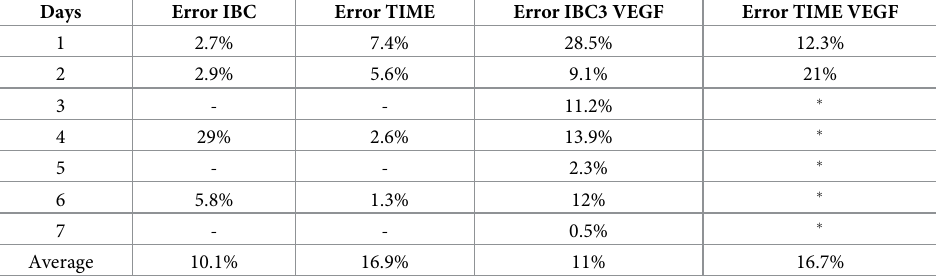
Table 2. Error between the ODE model output and cell culture and VEGF concentration data. All errors are relative errors between the model output and experimental data. The dashes (-) denote where the data is not available to calcu- late the quantity, and the asterisk ( � ) denotes when the data records a value of less than 2% of the baseline concentra- tion of 1100 pg/mL, thereby precluding computing the relative error (i.e., it would be near infinite). Days Error IBC Error TIME Error IBC3 VEGF Error TIME VEGF 2.7%